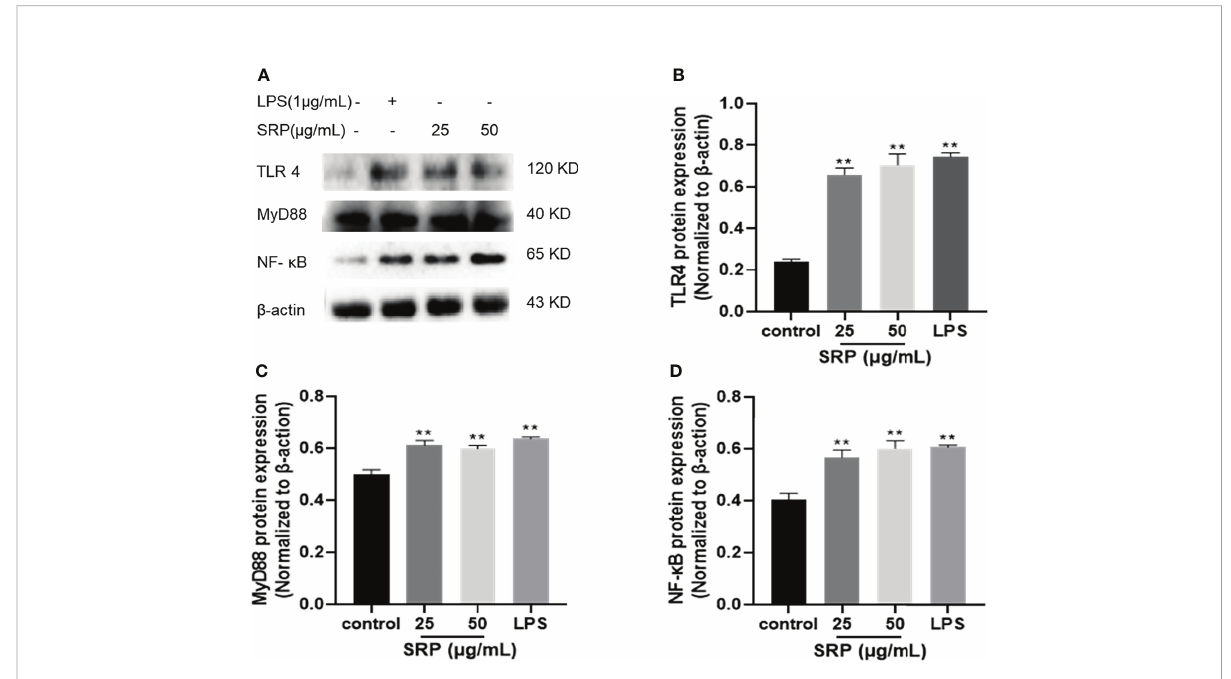
FIGURE 7 Effect of SRP on the protein expression levels of the TLR4/NF- k B pathway. (A) Western blot analysis of protein bands; (B) TLR4; (C) MyD88; (D) NF- k B protein expression. Signi fi cant differences with the control group: * p < 0.05 and ** p < 0.01.